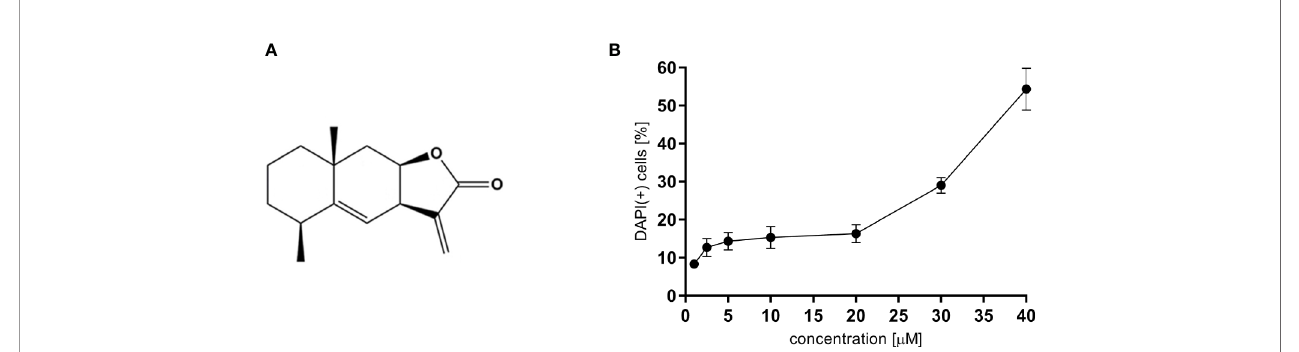
FIGURE 1 | (A) The chemical structure of alantolactone, and (B) the cytotoxicity of alantolactone in THP-1